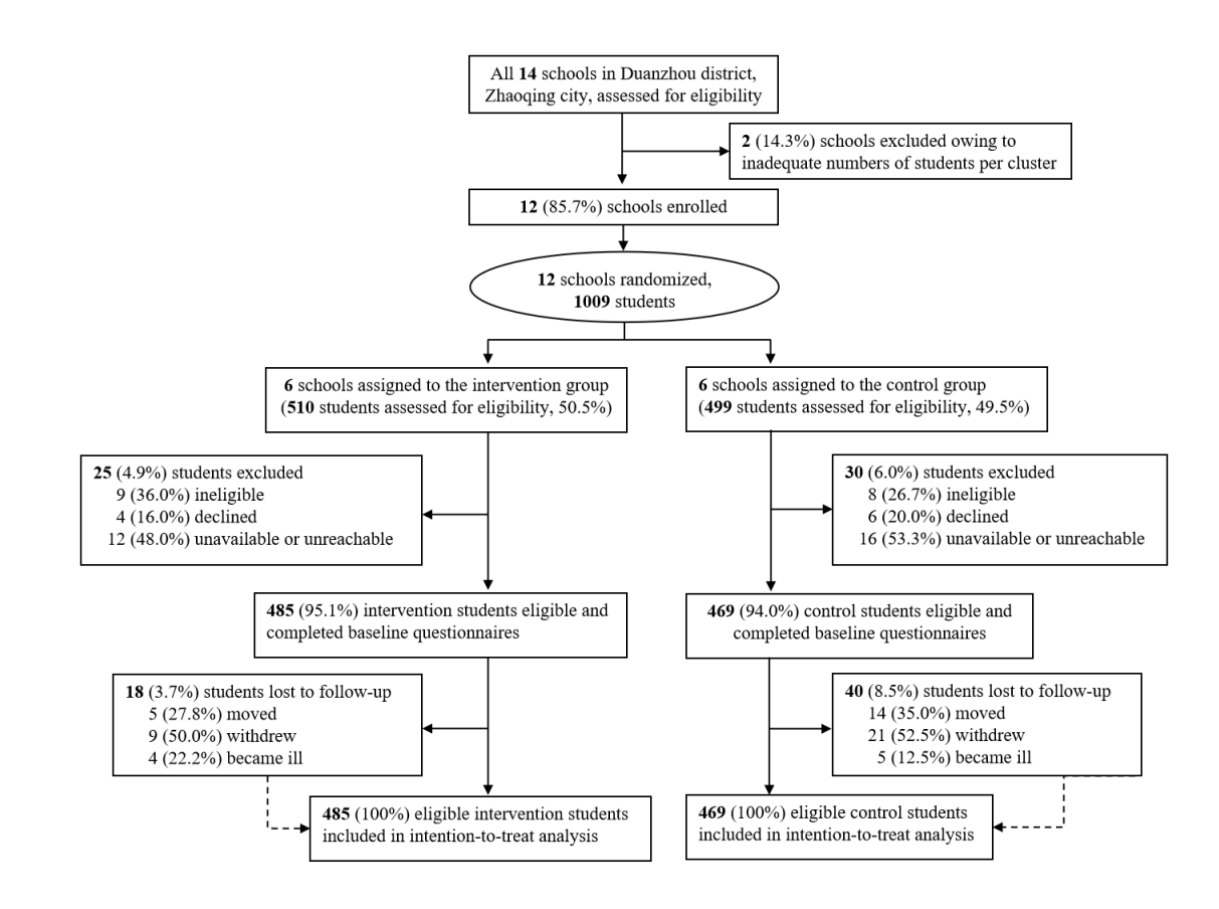
Figure 1. Flow diagram for the